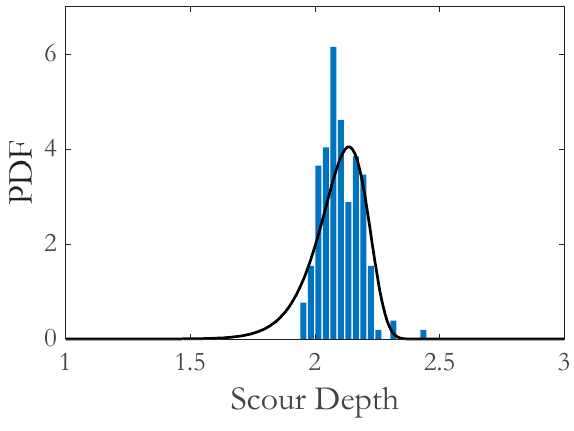
Figure 6. Probability distribution of SD [22].